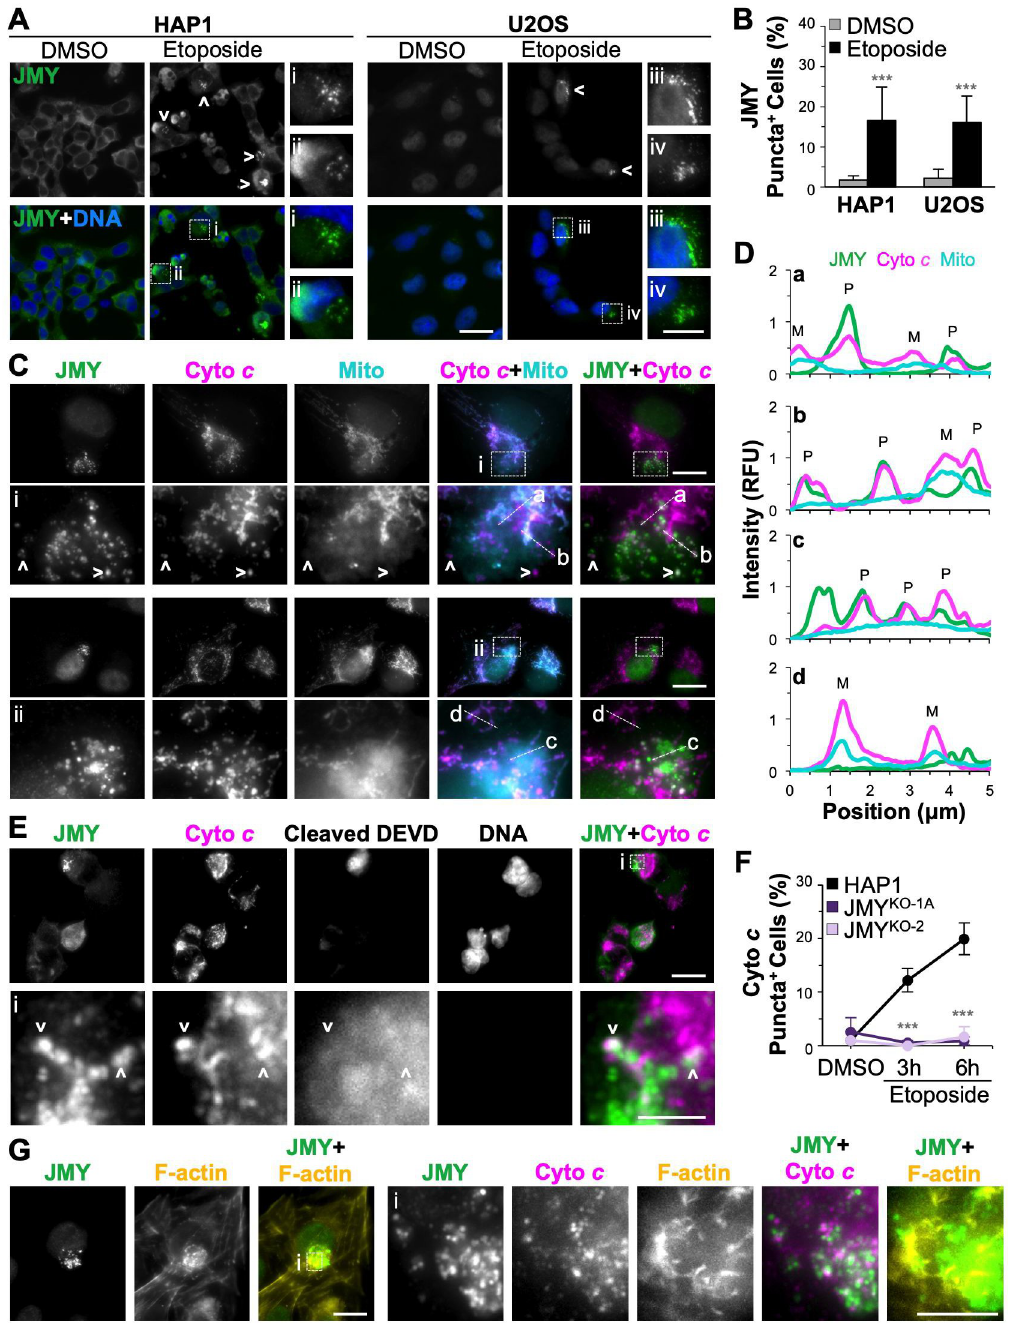
Fig 9. JMY colocalizes with cytochrome c puncta and is required for their assembly into F-actin-associated cytoplasmic clusters. (A) HAP1 and U2OS cells were treated with DMSO, 5 μ M etoposide, or 10 μ M etoposide for 6h before being fixed and stained with an antibody to JMY (green) and DAPI (DNA; blue). Arrowheads and magnifications (i-iv) highlight examples of cytosolic JMY puncta. Scale bars, 25 μ m, 10 μ m. (B) The % of cells with JMY puncta was calculated in ImageJ by counting the cells containing JMY puncta and dividing by the total number of DAPI-stained nuclei. Each bar represents the mean % ± SD from 3 experiments (n = 1,149–1,576 HAP1 cells per bar; n = 466–489 U2OS cells per bar). Significance stars refer to comparisons between DMSO and etoposide treatments. (C) U2OS cells were treated with 10 μ M etoposide for 6h and incubated with MitoTracker (Mito; cyan) before being fixed and stained with antibodies to JMY (green) and cyto c (magenta). Arrowheads and magnifications (i,ii) show examples of cytosolic JMY and cyto c puncta. Scale bars, 10 μ m. (D) 5 μ m lines were drawn through the magnified images in (C) using ImageJ to measure the pixel intensity profiles for JMY, cyto c ,